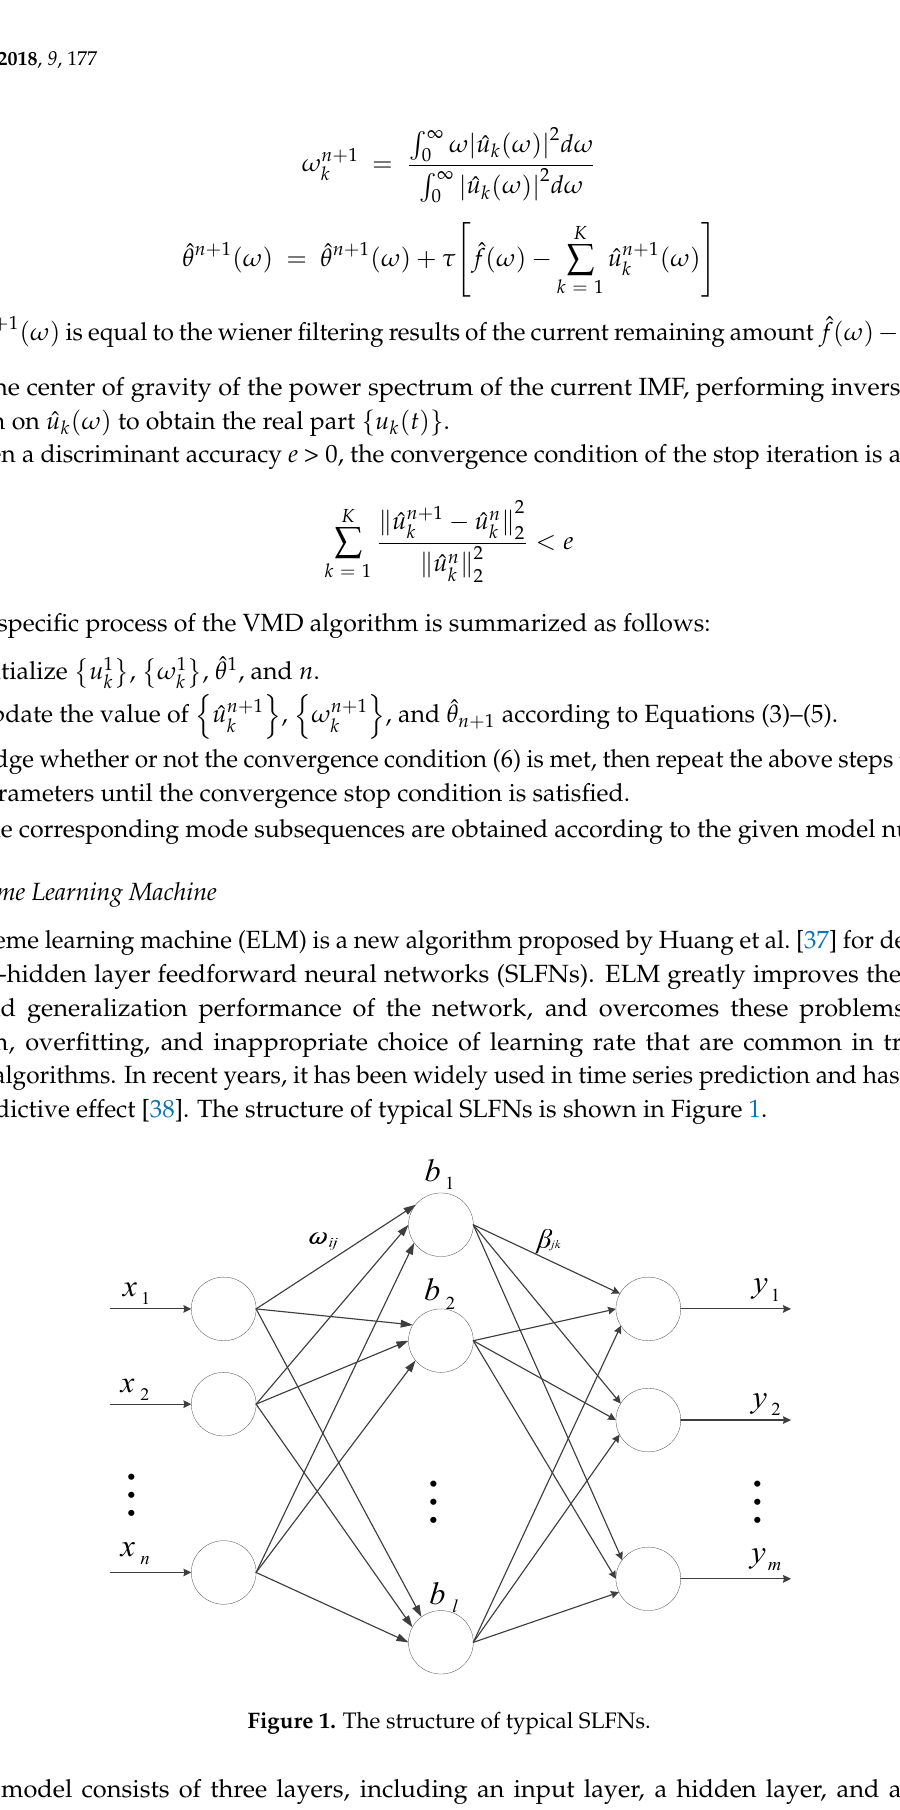
Figure 1. The structure of typical SLFNs.